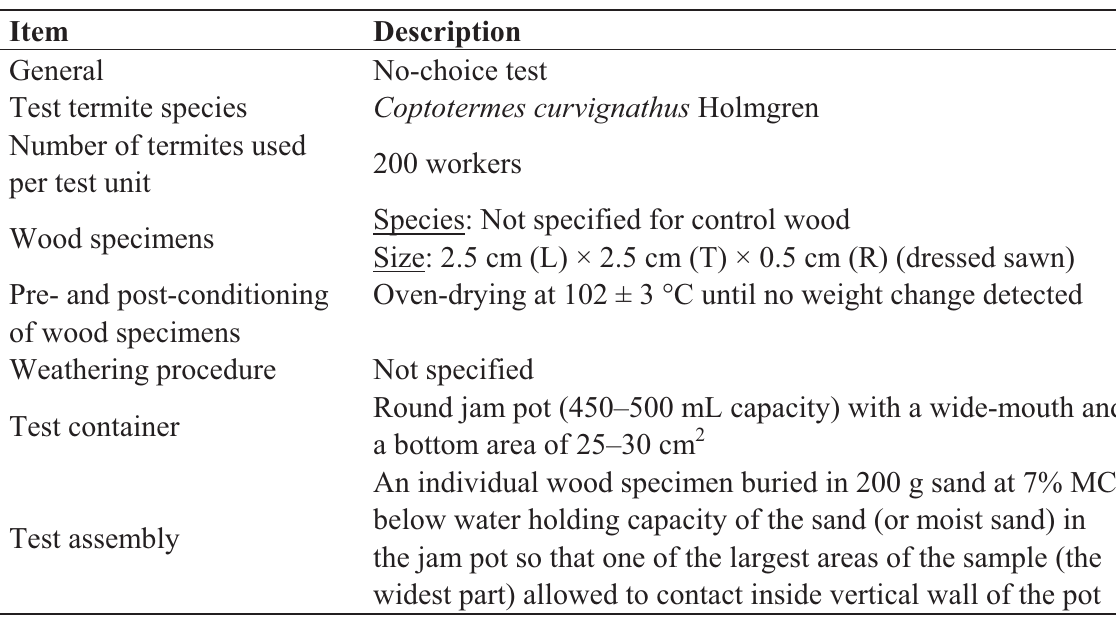
Table 1. Subterranean termite test method (SNI 01.7207–2006)